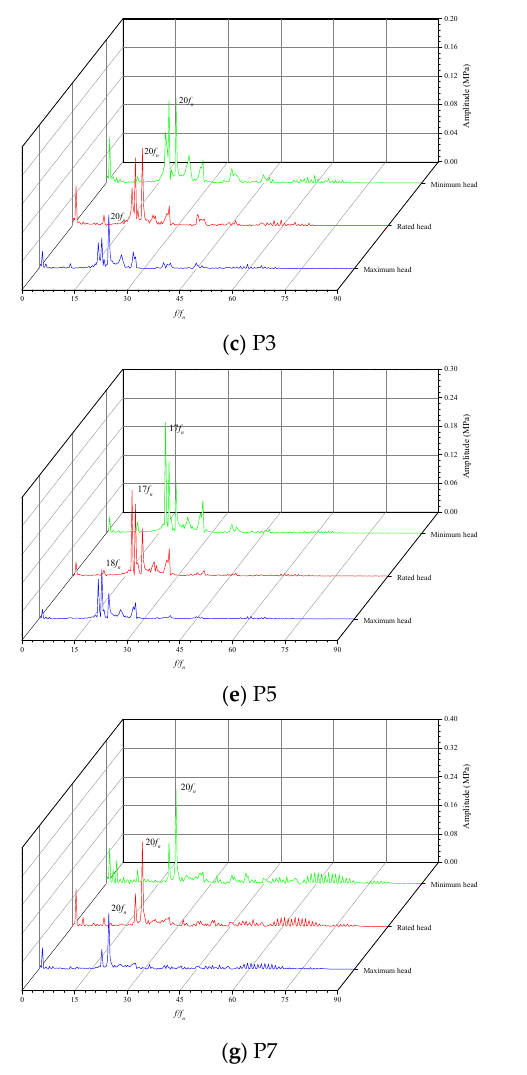
Figure 12. Frequency spectra of the dynamic stress at monitoring points.